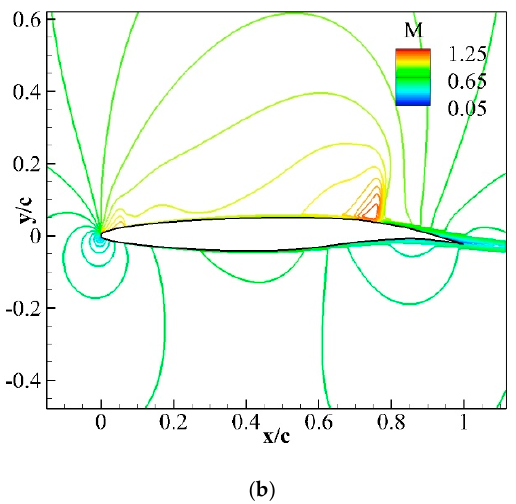
Figure 19. Computed ( a ) coefficient of pressure and ( b ) Mach contours for flow over the VCCTEF 33 airfoil at a zero angle of attack.